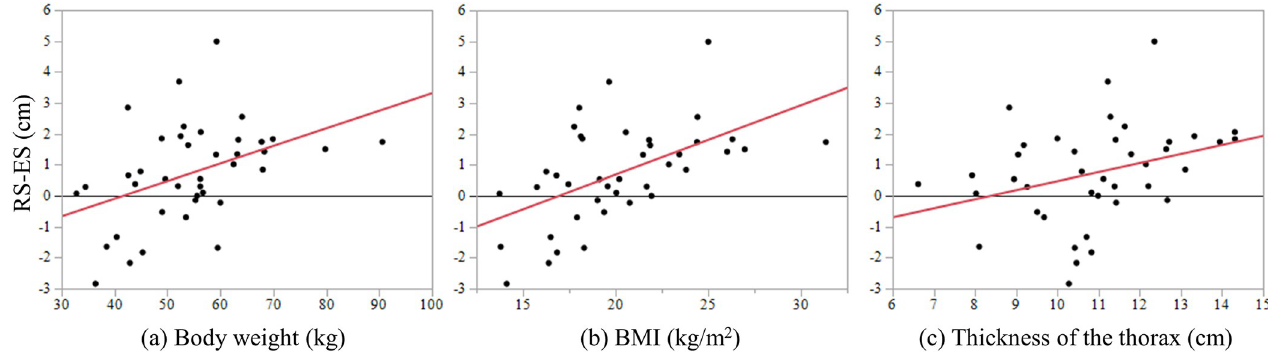
Fig 3. Relationships between the three factors and differences in reconstruction lengths. The three factors associated with the difference between the length of the retrosternal route and that of the esophagus–stomach (RS–ES) were analyzed using Spearman’s rank correlation coefficient; positive correlations were observed with each factor. (a) Body weight: ρ = 0.42, p = 0.007; (b) BMI: ρ = 0.52, p = 0.001; (c) Thickness of the thorax: ρ = 0.39, p = 0.01.